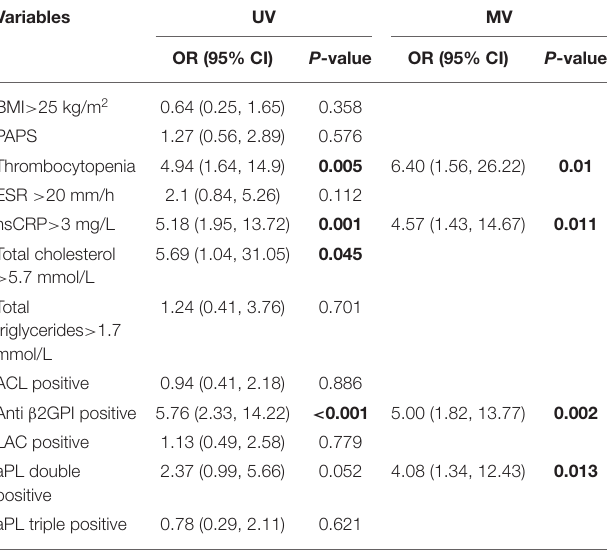
TABLE 3 | Univariate and multivariate logistic regression analyses for variables predictive of PVT in APS patients. n ( N = 34) Variables UV